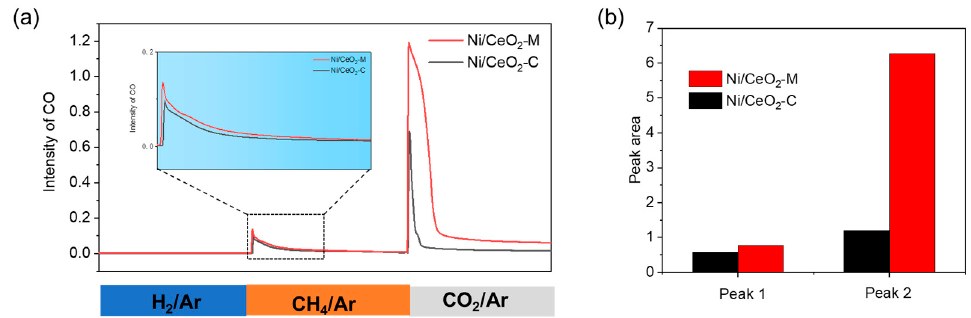
Figure 8. ( a ) Two-step TSR profile; ( b ) peak area of CO of Ni/CeO 2 -C and Ni/CeO 2 -M